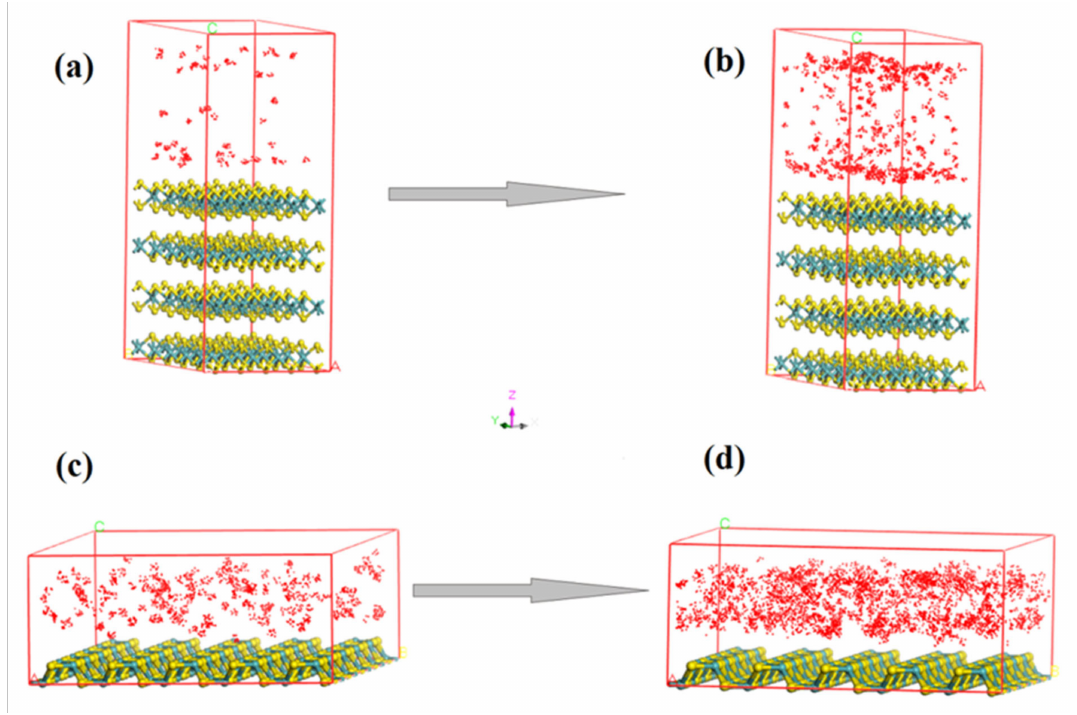
Figure 4. Sorption saturation status of H 2 O molecule on the supercell (5 × 5 × 2) of (001) surface at ( a ) 1 bar and ( b ) 10 bar, and (110) surface at ( c ) 1 bar and ( d ) 10 bar (one red point represents one water molecule; yellow ball represents sulfur atom; blue ball represents molybdenum atom).